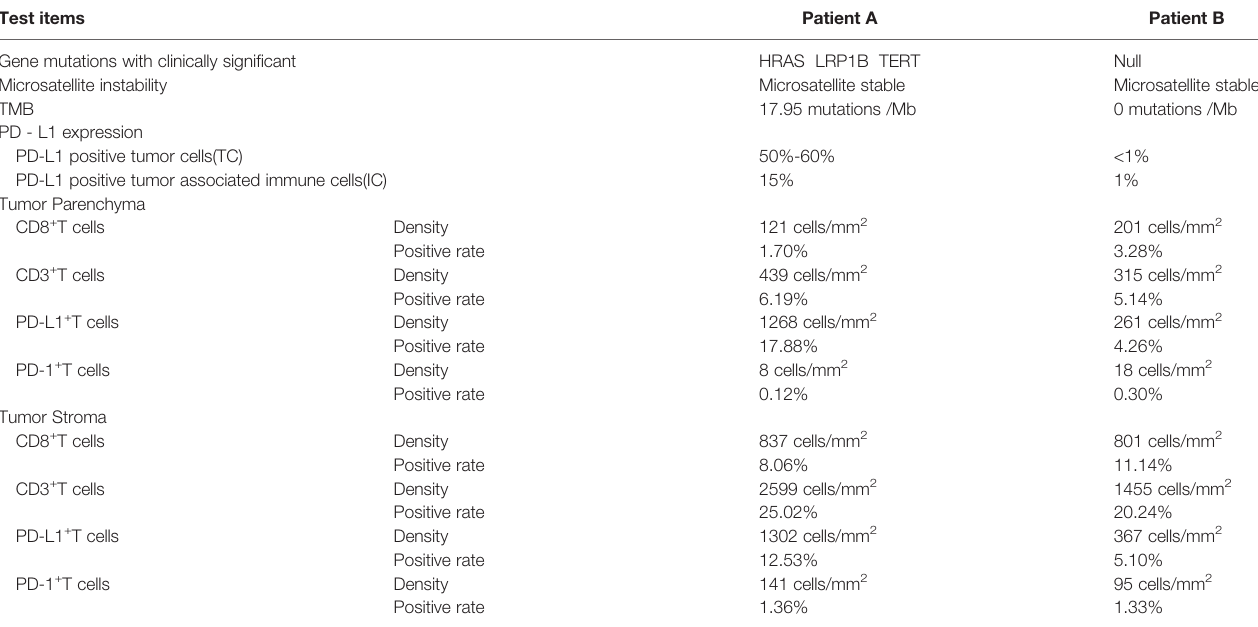
TABLE 1 | Detection of biomarkers in patients A and B. Test